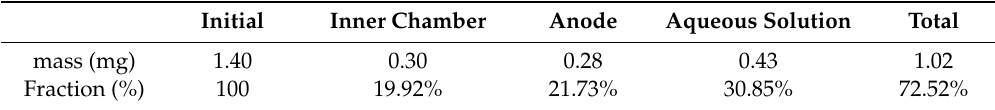
Table 1. The distribution of adsorbed TCS in abiotic reactor.